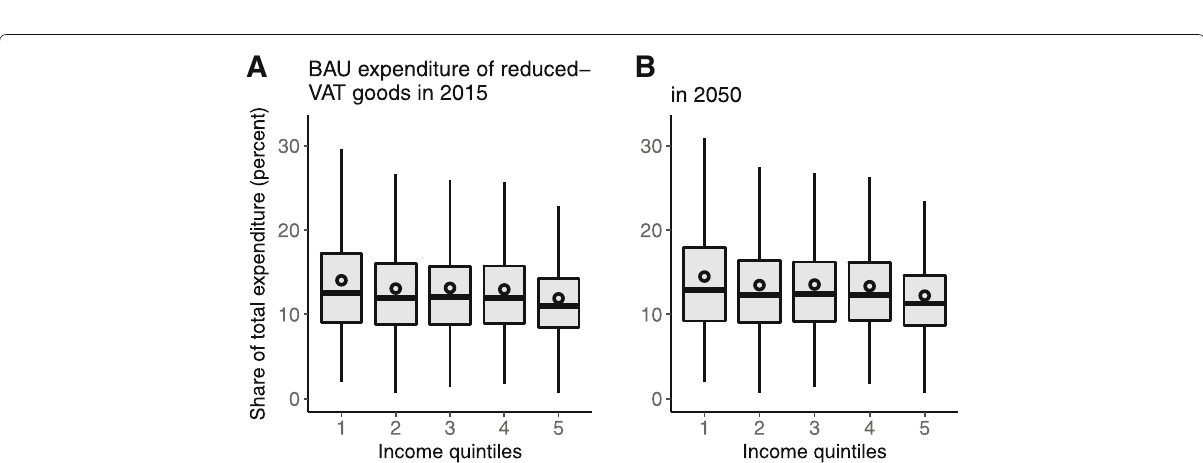
Fig. 5 Distribution of share of expenditures liable to VAT reductions in the VAT-reducing recycling scenarios within and across income quintiles in 2015 ( a ) and in 2050 ( b ). Note: Income quintiles are according to allocation by the statistical office. The circles show mean values